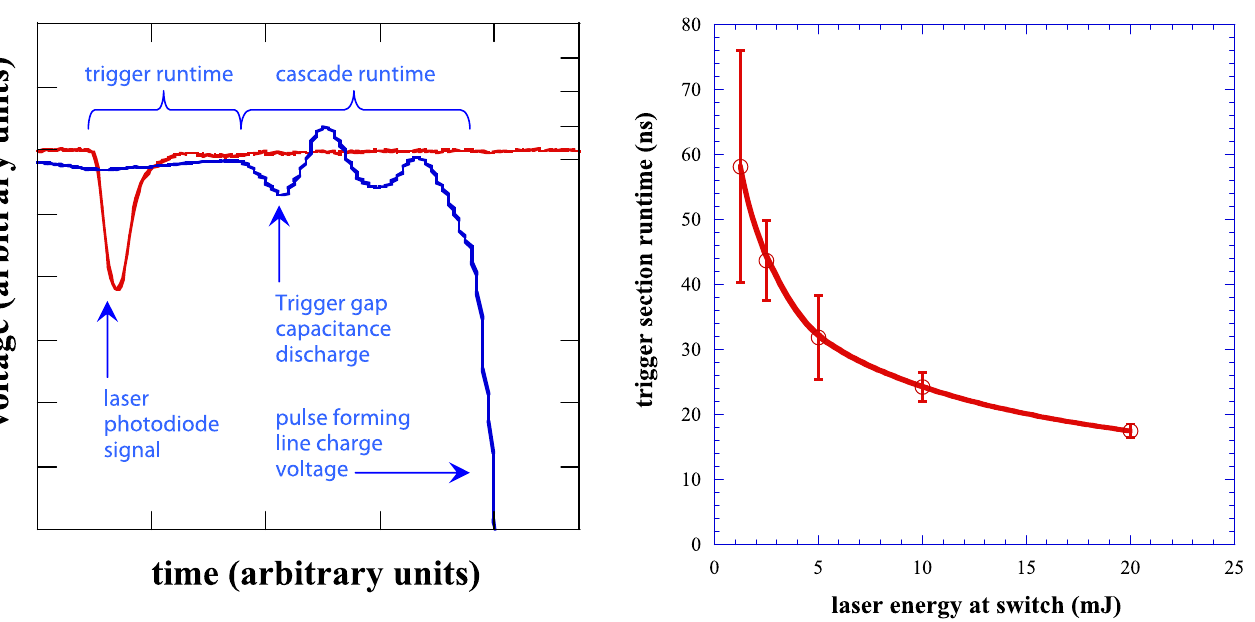
FIG. 18. (Color) Average trigger runtime as a function of laser energy. The laser beam is focused at the center of a 4.6 cm gap with a 50 cm focal length lens. Vertical bars represent a 1 - (cid:2) timing jitter of ten-shot